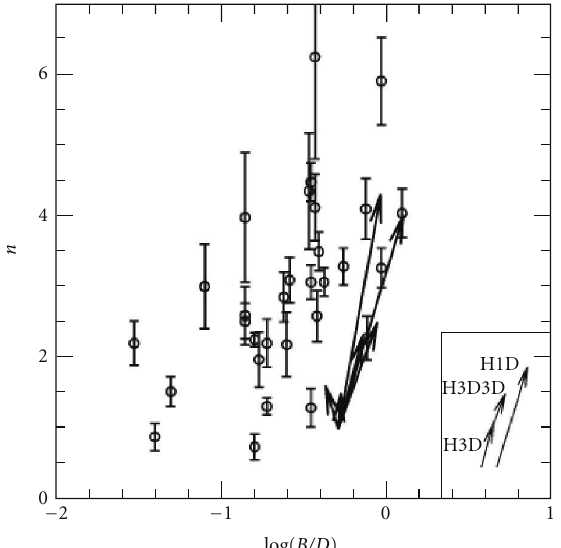
Figure 18: Growth vectors of the bulges in the n -log( B/D ) plane for the accretion models by [243]. Each arrow starts at the location of the original model and ends at the n and B/D derived from the two- component fit of the surface mass density profile of the models. The points represent the distribution of n versus log( B/D ) for bulges of galaxies from [93]. See more details is